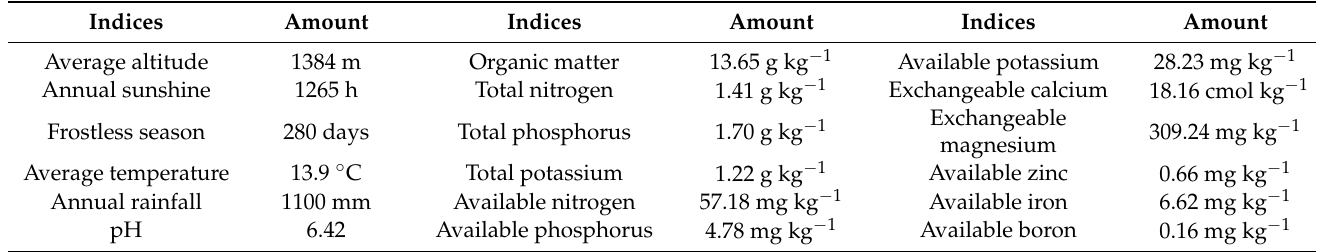
Table 1. The climatic and nutritional information of R. roxburghii